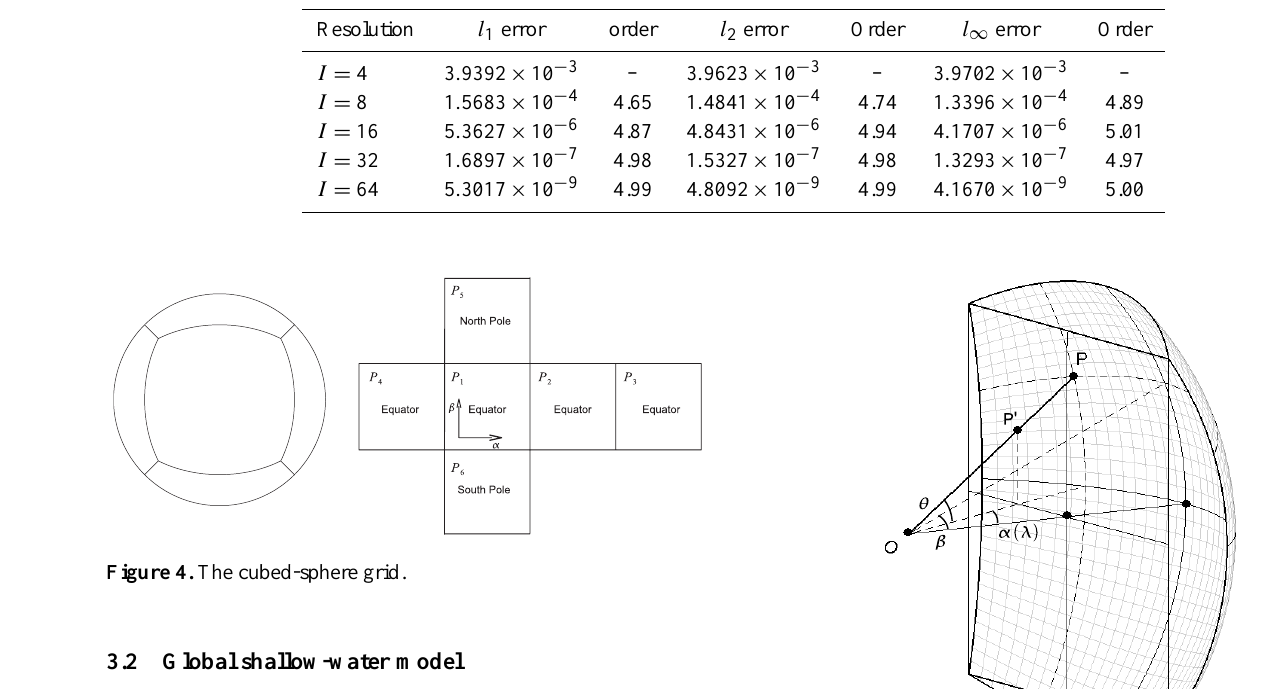
Table 2. Numerical errors and convergence rates for advection of a sine wave.